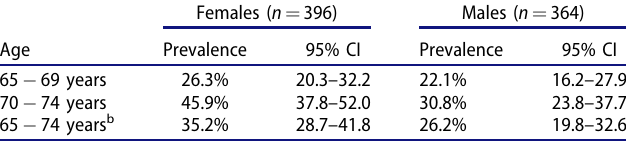
Table 3. Prevalence of cataract in the population survey in Tierp, by age and gender.